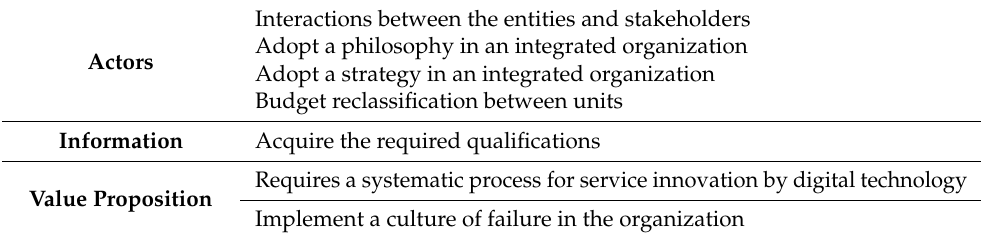
Table 3. Challenges of industrial cloud integration in service systems